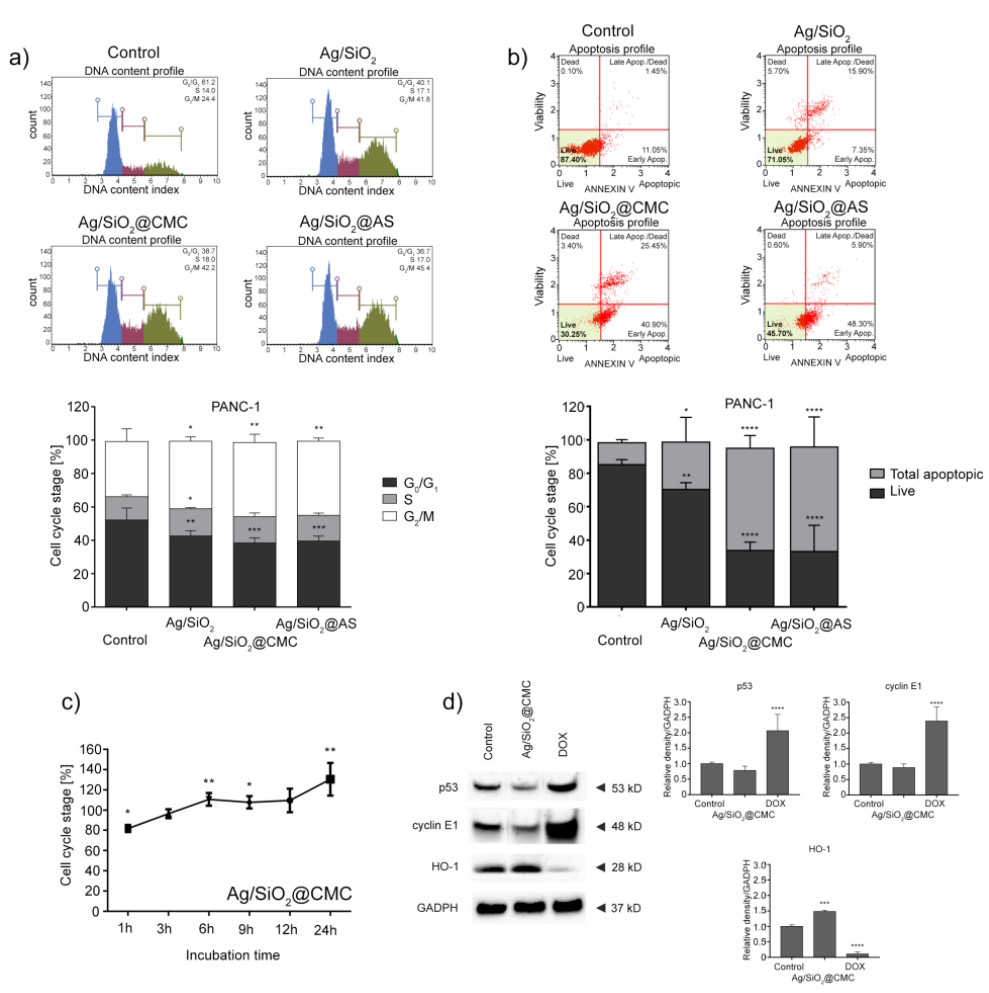
Figure 9. Impact of the tested nanocomposites at a 30 mg / L concentration on regulating the cell cycle ( a ) and inducing apoptosis ( b ) in the PANC-1 cells. E ff ect of the tested Ag / SiO 2 @CMC nanocomposite on the level of reactive oxygen species (ROS) in the PANC-1 cells. Data normalized to the untreated cells (control) ( c ). Impact of Ag / SiO 2 @CMC on the expression of the p53, cyclin E1, and HO-1 proteins in the PANC-1 cells. The densitometric analysis of these proteins was normalized to GADPH ( d ).